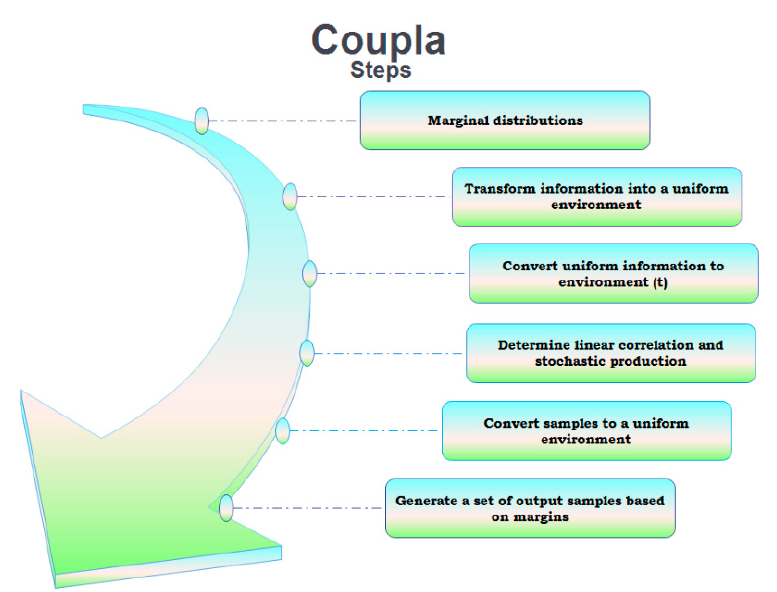
Figure 1. Flowchart of the steps of Proposed Method.